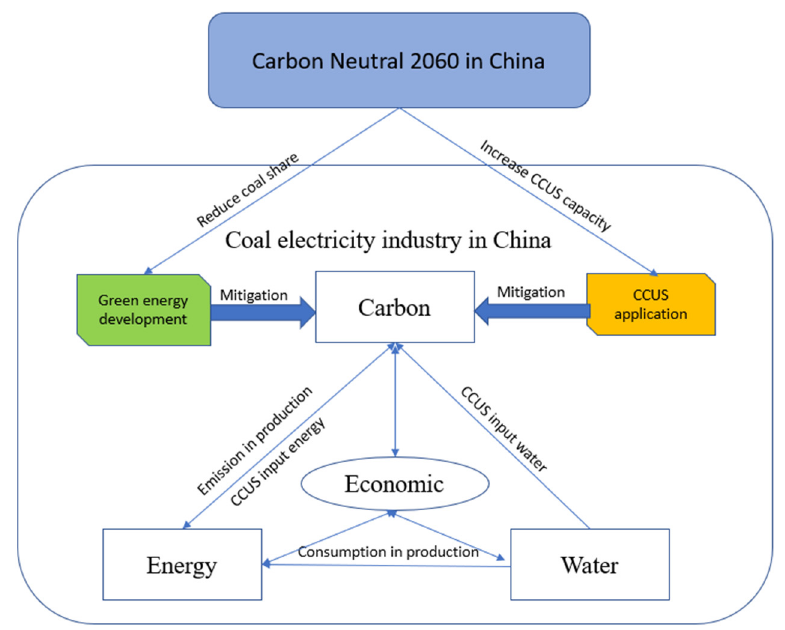
Figure 1. Conceptual framework of ATPCC design.